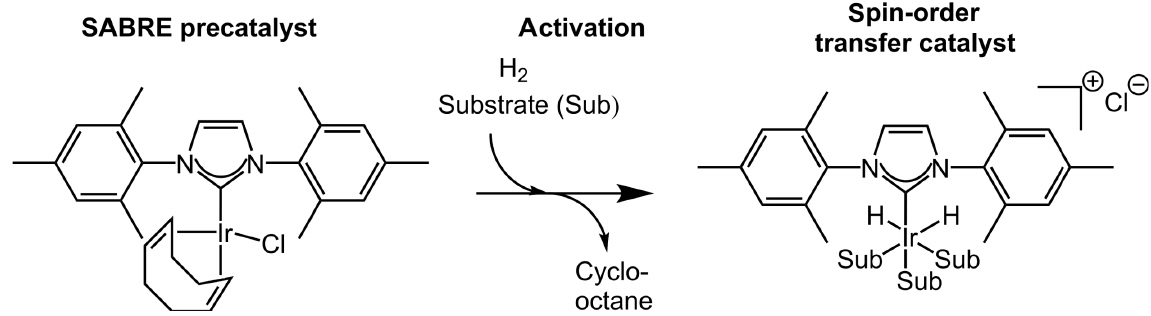
FIG. 6. Chemical activation of the SABRE catalyst precursor to become the SABRE active spin-order transfer